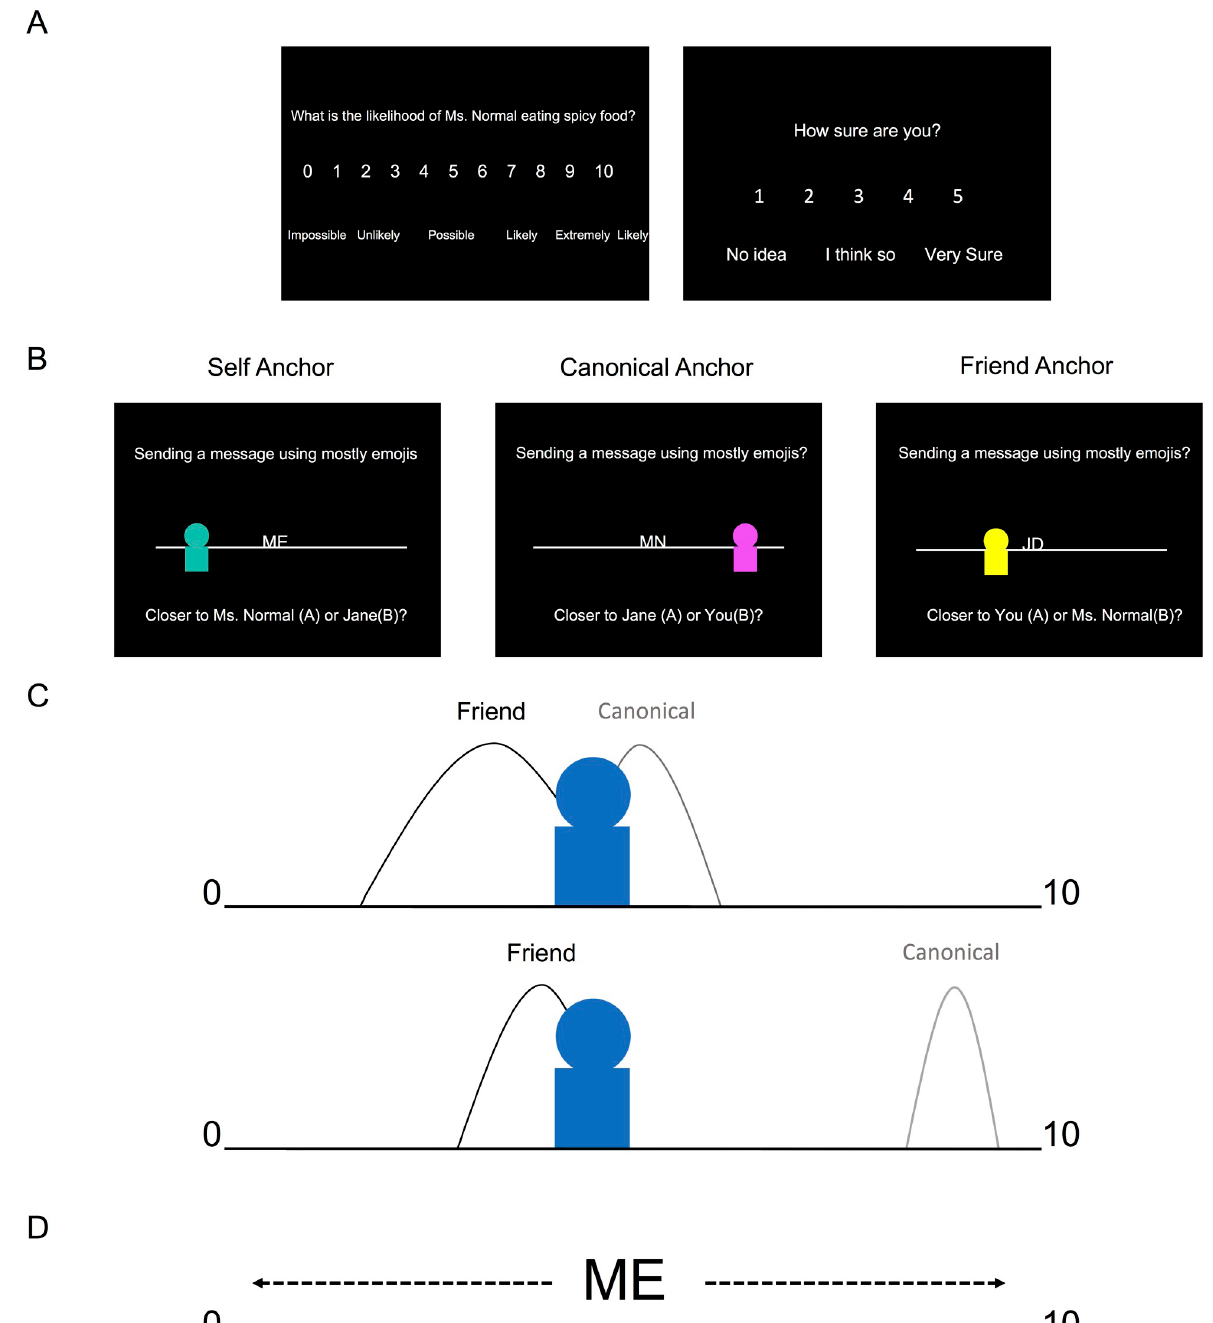
Fig 1. Experiment. A. Right before fMRI scanning, subjects were instructed to choose a friend with a different personality of the same gender. Subsequently, subjects rated from 1–9, on a 0–10 scale, how likely (likelihood) they (self), a close friend (friend), and the typical person (canonical) were to partake in a variety of everyday scenarios (e.g., eat spicy food, read a book, cycle to work). To allow for strangers with more extreme ratings than the familiar individuals in the fMRI paradigm, subjects were restricted to rating between 1–9. Subjects also reported their confidence, on a 1–5 scale, for each scenario. B. fMRI paradigm. During a forced-choice task, subjects made a decision on the relative proximity of a stranger’s likelihood rating for an everyday scenario relative to the likelihood ratings for the self, friend, and canonical individuals for that same scenario. On each self- paced trial (max. allowed response time 9 s), subjects viewed a personal preference for a new stranger presented relative to one of the known individuals’ initials (anchor) on a number line. Subjects had to determine which one of the two remaining (i.e., nonanchor) familiar individuals was closer to the stranger’s rating. Crucially, the anchor individual (e.g., ME = self; MN = canonical “Mr./Ms. Normal;” JD = friend’s initial) was always placed in the middle of the scale, ensuring that subjects had to use memory of their ratings made before fMRI scanning to infer the stranger’s